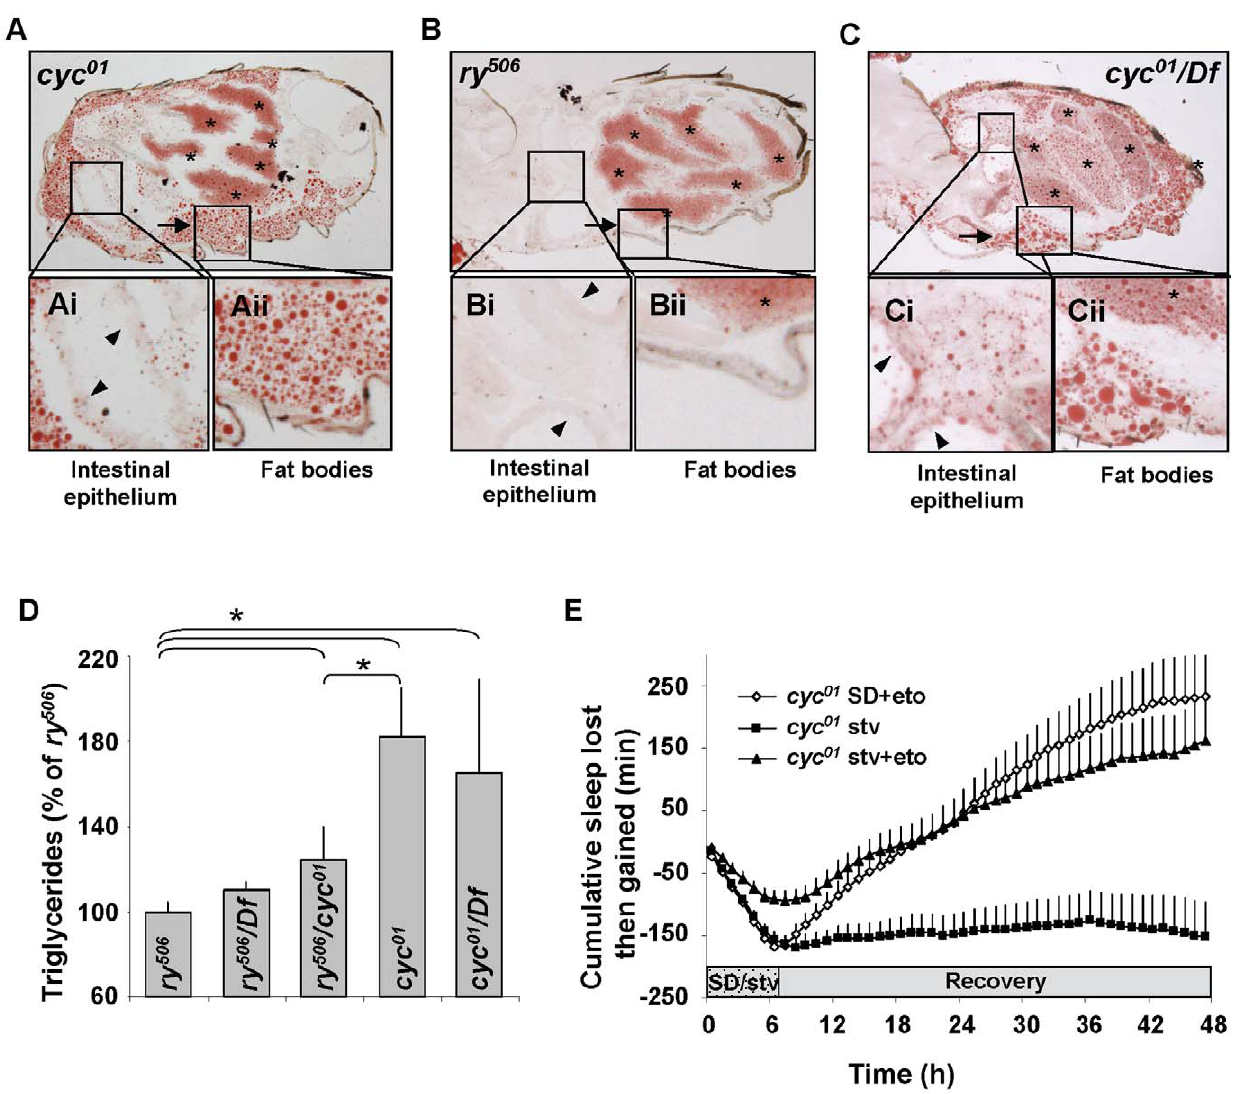
Figure 3. cyc 01 flies have increased adiposity. (A) Representative Oil Red O staining, which stains lipids red, reveals high levels of fat stores in the abdomen of female cyc 01 flies. Boxed areas (Ai and Aii) are presented at higher magnification. * denotes developing eggs, and arrowheads are placed in the lumen of the gut and point to gut epithelial cells. Arrows point to the location of the fat bodies which abut the cuticle (9 flies were examined). (B) Representative section of ry 506 abdomen, the background control for cyc 01 . ry 506 have little accumulation of lipid droplets in the abdomen in similar areas to (A) as revealed by Oil Red O staining. Boxed areas (Bi and Bii) are presented at higher magnification (9 flies were examined). (C) Representative section of Oil Red O stained cyc 01 /Df abdomen reveals high levels of fat stores. (Ci and Cii) are presented at higher magnification (9 flies were examined). (D) Organismal triglyceride (TG) levels are elevated in cyc 01 , cyc 01 / Df , and cyc 01/ ry 506 flies compared to ry 506 controls; one-way ANOVA for Genotype F [ 4,38 ] =3.2; * p , .05 modified Bonferroni Test; n $ 7 groups/condition, a group was comprised of 10 flies. (E) An elevated homeostatic response is observed in cyc 01 mutants that were starved for 7 h ( n =45) on 1% agar containing 25 m M etomoxir. No further increase in homeostasis is found in cyc 01 sleep deprived for 7 h on food containing 25 m M etomoxir ( n =72); compare with Figure 1A. Siblings starved in the absence of etomoxir are shown for comparison ( n =92); all experiments were conducted in